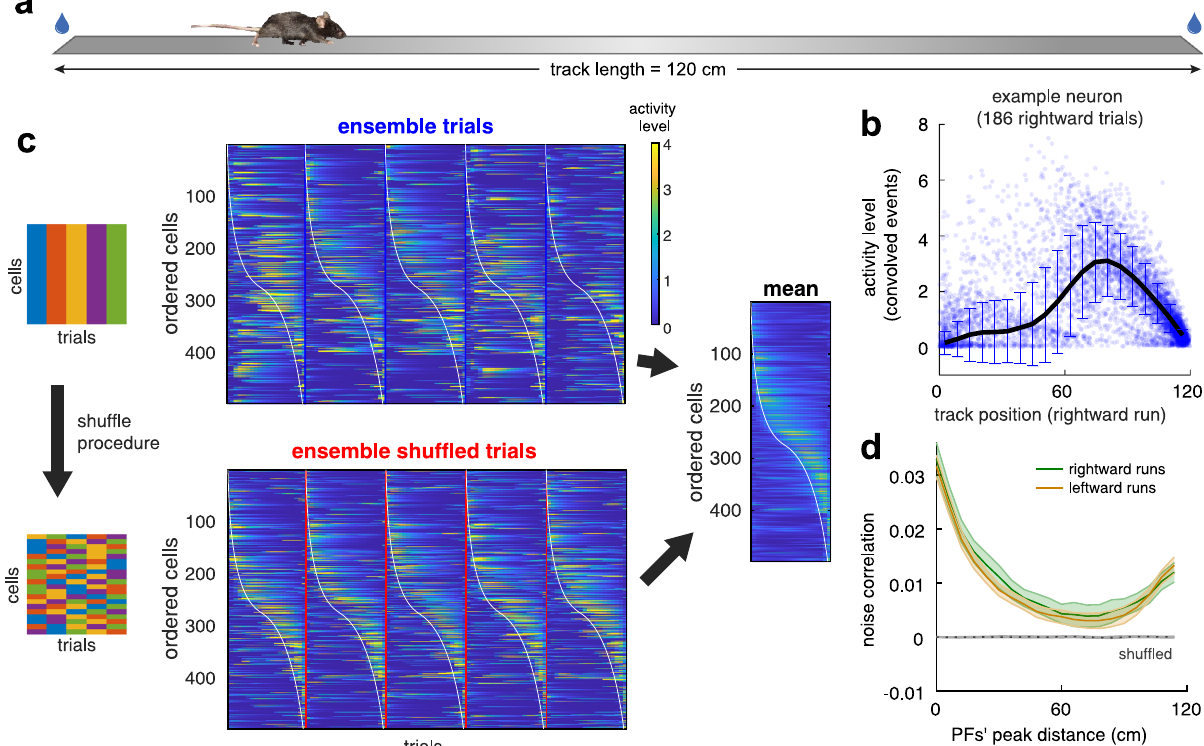
Fig. 1 Noise correlation in the neuronal activity of the mouse CA1 area. a Mice ran back and forth along a linear track of length L = 120 cm and collected water rewards at each end of the track. b Example neuron ’ s activity level for different spatial locations. Activity level based on normalized amplitudes of detected events convolved with an alpha function (see Methods) for each visit to each spatial location (dots) relative to mean values across visits (continuous line). Error bars are the 95% con fi dence intervals over 186 trials. c Left: Schematic of the shuf fl ing procedure, where we mixed neurons ’ responses (columns) across different trials (rows) for the entire track. Center: Stack of maps of individual cells ’ trial-by-trial PFs along the track for cells monitored together within a single imaging session, ordered by the maximum activity level for a given rightward running direction (for one session from animal 2022). Individual trials show response fl uctuations relative to mean responses (Right) (the white line generated for visualization purposes was obtained from the leftmost end of PF ’ s widths (smoothed across neighboring neurons/horizontal lines) computed on the distribution of mean responses (Right)). Right: The mean response over trials for all recorded cells was unaffected by the shuf fl ing procedure. d Noise correlations between neurons as a function of distance between PF peaks (3,941,140 pairs from 110 sessions from 12 mice). The solid lines and shaded areas represent means and 95% con fi dence intervals, respectively. The shuf fl ing procedure drastically reduced noise correlations in the shuf fl ed data. Source data is provided as a Source Data fi